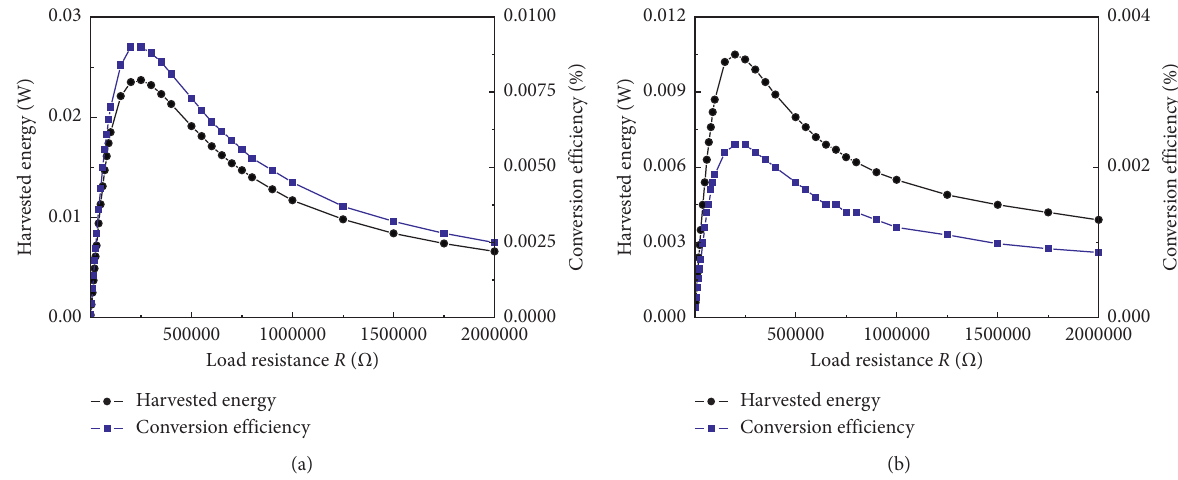
Figure 11: Harvested energy and conversion efficiency of the friction system with different external electric load resistances in the friction laws I (a) and II